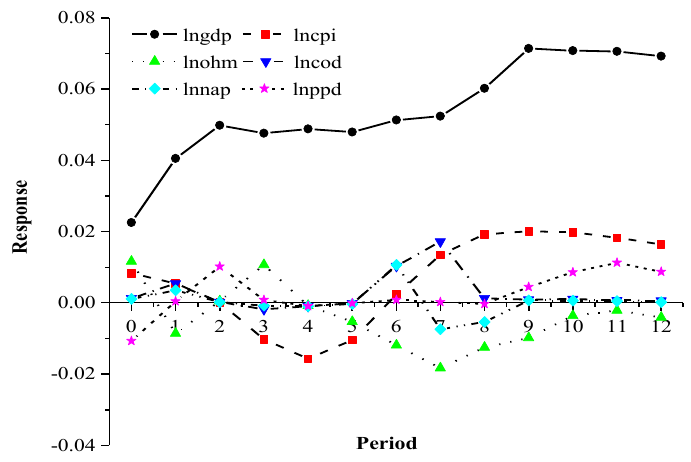
Figure 2. Impulse responses of GDP and CPI and of the four pollutant